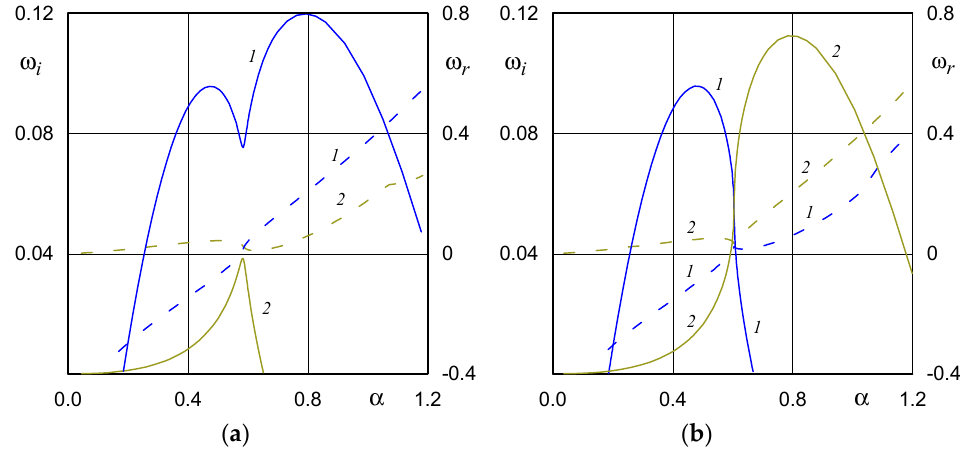
Figure 5. The growth rate ω i (solid lines) and oscillation frequency ω r (dashed lines) vs. the wavenumber for modes 1 and 2 (curves 1–2) at Re = 140: ( a ) q = 0.68; ( b ) q = 0.69. In the particular case, when Re = 115 at the branch point q = 0.65 of modes 1 and 2, perturbations (8) generate standing waves: ω 1 r = ω 2 r = 0, ω 1 i